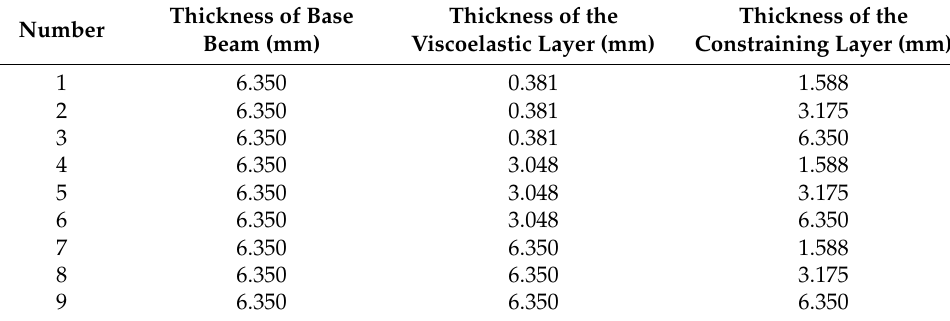
Table 4. Thickness of each layer of cantilever EVES